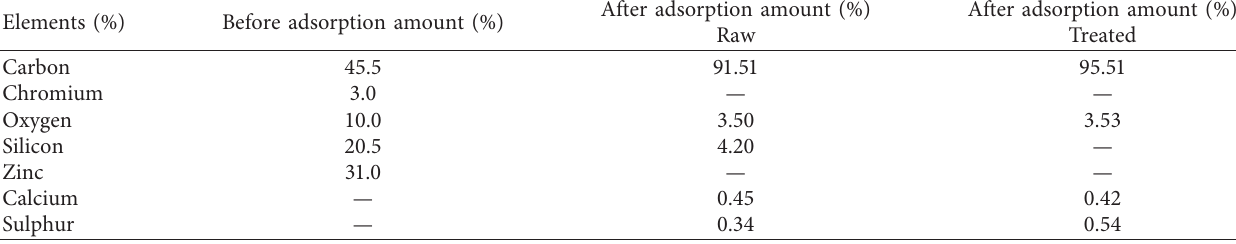
Table 3: Percentage composition of the elements in Moringa oleifera seed husk (MOSH) activated carbon.